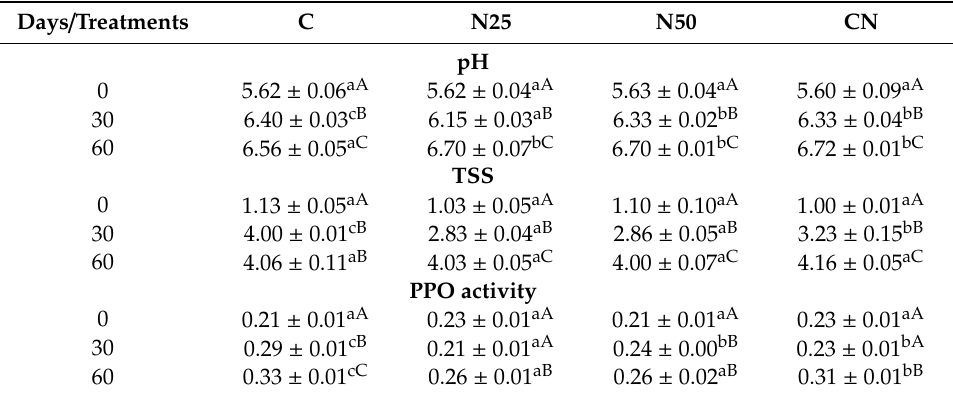
Table 1. Physicochemical changes in avocado during